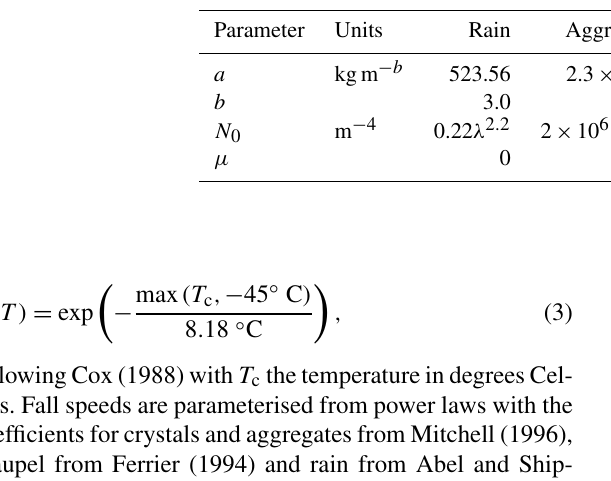
Table 1. Parameters used to define the mass–diameter relationships (Eq. 1) and particle size distributions (Eq. 2), where f (T ) is given by Eq.